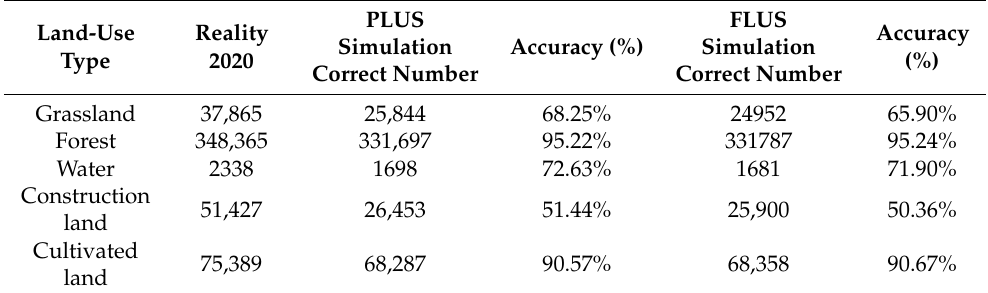
Table 9. Comparison of the pixel number of simulated and observed land use in the ECA of western Beijing in 2020.